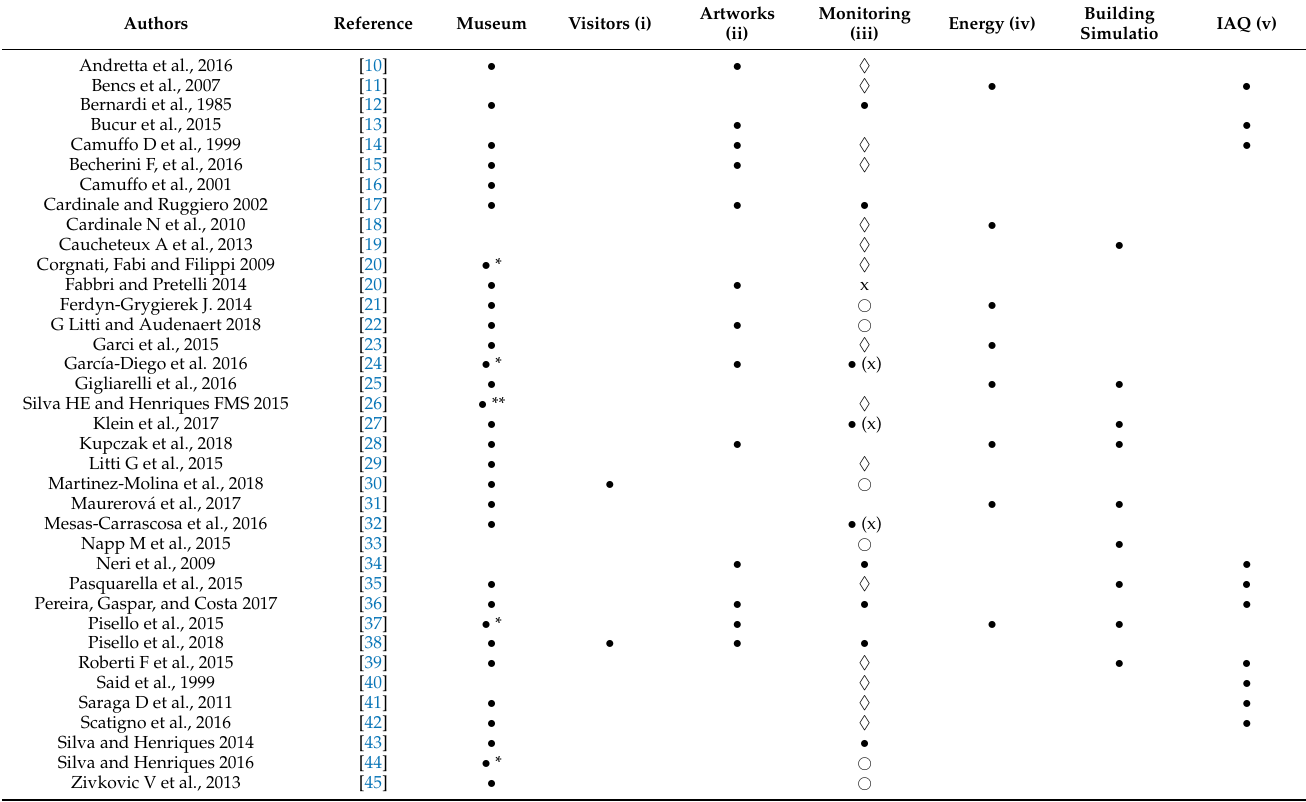
Table 1 report a list of scientific literature about microclimate in heritage building. Table 1. Literature on indoor microclimate in heritage